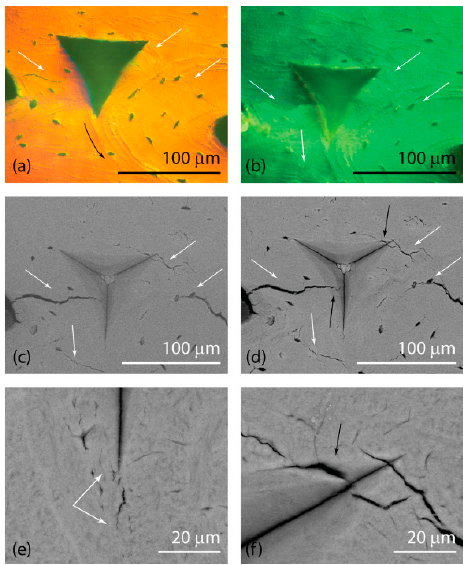
Figure 5. Indentation site on the transverse section of human cortical bone. Images are of ( a ) as-indented; ( b ) dehydrated; ( c ) ESEM (environmental scanning electron microscope) and ( d ) SEM. The bottom corner of the indentation; ( e ) shows a crack with 1 = 10 µ m, which is one of the two cracks emanated from indent corners among 30 corners. High-magnification imaging of the top right corner; ( f ) revealed that no cracks were generated from this indent corner [21]. Reproduced with permission from J.J. Kruzic et al., Journal of the Mechanical Behavior of Biomedical Materials; published by Elsevier, 2009.